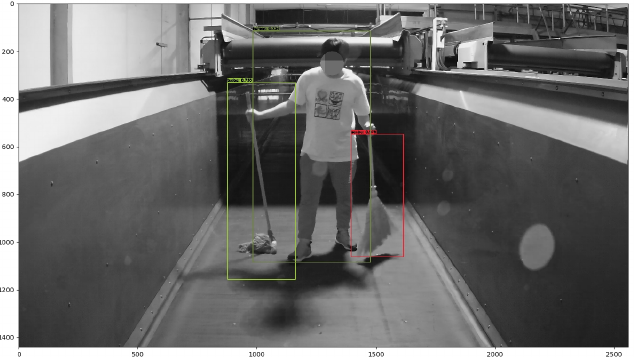
Figure 7. Foreign object detection result image. The left box detects a mop, the middle box detects people and the right box detects a